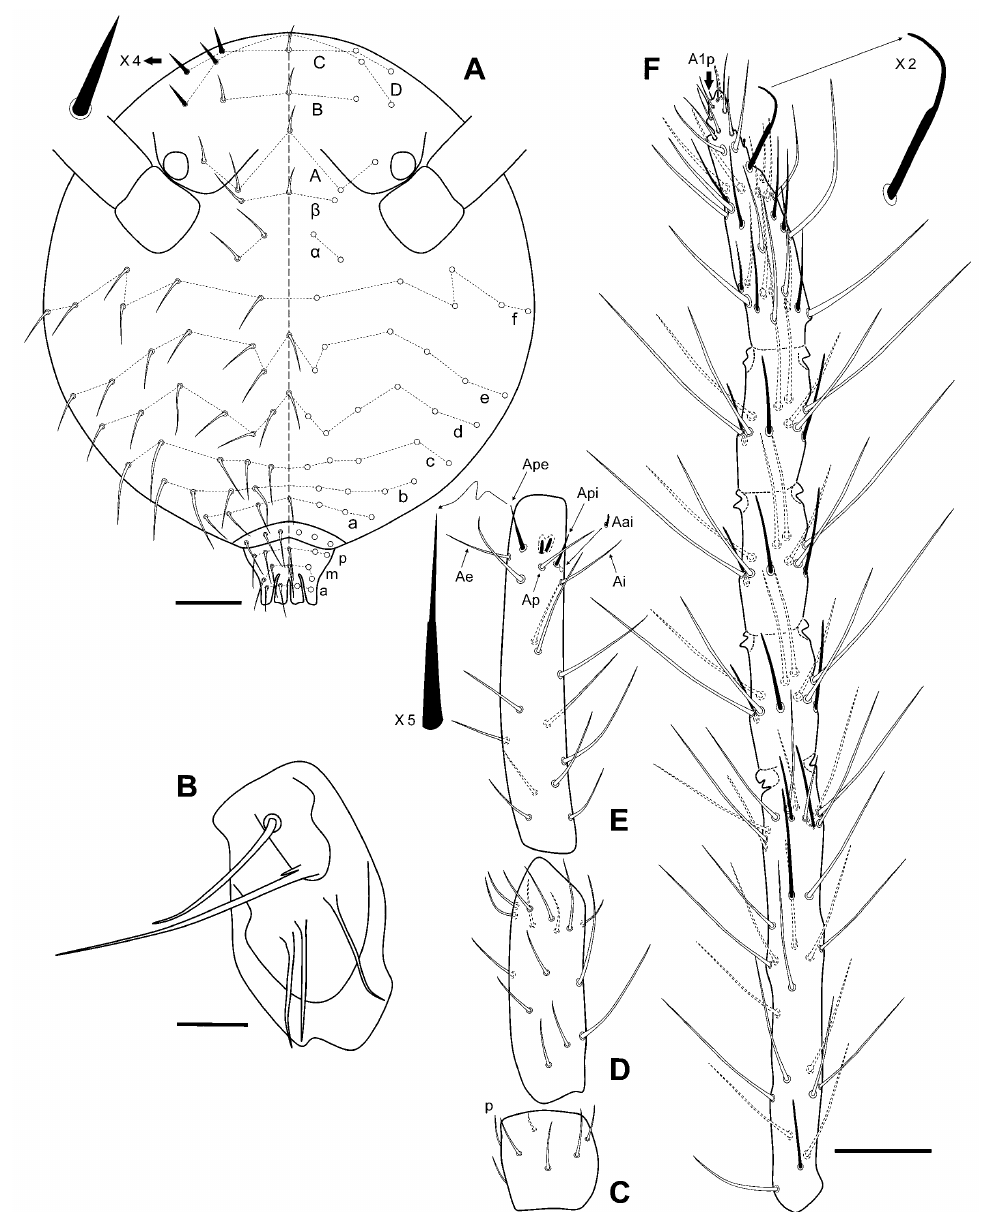
Figure 4. Pygmarrhopalites custodum Baquero and Jordana sp. nov.: ( A ) head, dorsal view; ( B ) maxillary palp and sublobal plate; ( C – F ) antennal segments I to IV (scale bars: A and C–F, 0.04 mm; B, 0.01 mm). Foreleg (Figure 5A and 5D): precoxae 1, 2, and coxa with 1, 0, 1 chaetae, respectively. Trochanter with three anterior and 1 posterior chaetae. Femur with 12 chaetae, a4 turned perpendicularly to the longitudinal axis of the segment, p1 and p3 thin and short. Tibio- tarsus with 43 chaetae: whorl I with 9 chaetae among which Ja curved and somewhat thickened, whorls II–V with 8, 8, 8, and 7 chaetae respectively; region F with 3 primary FP